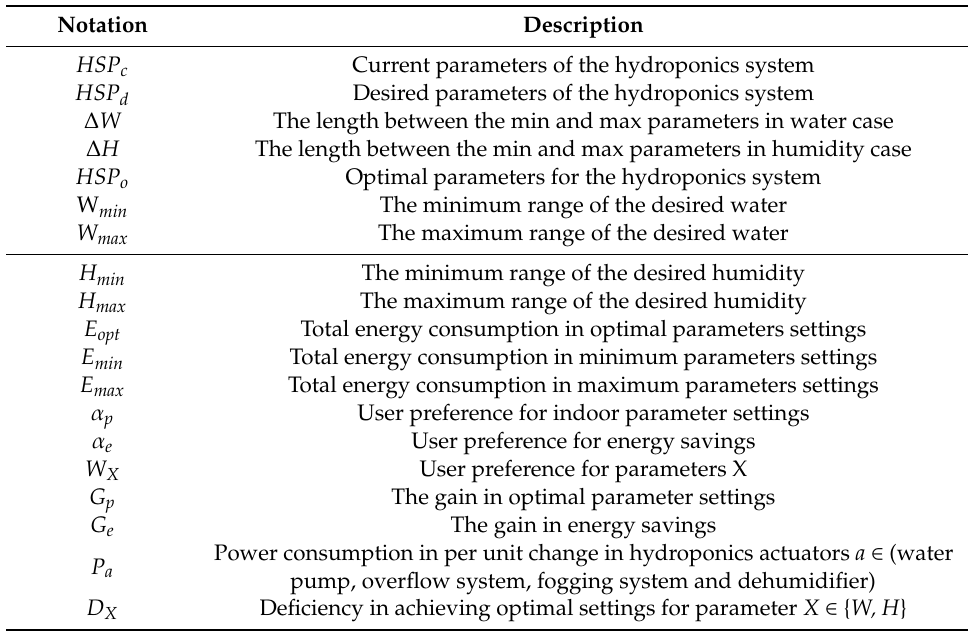
Table 1. Description of notations used in the